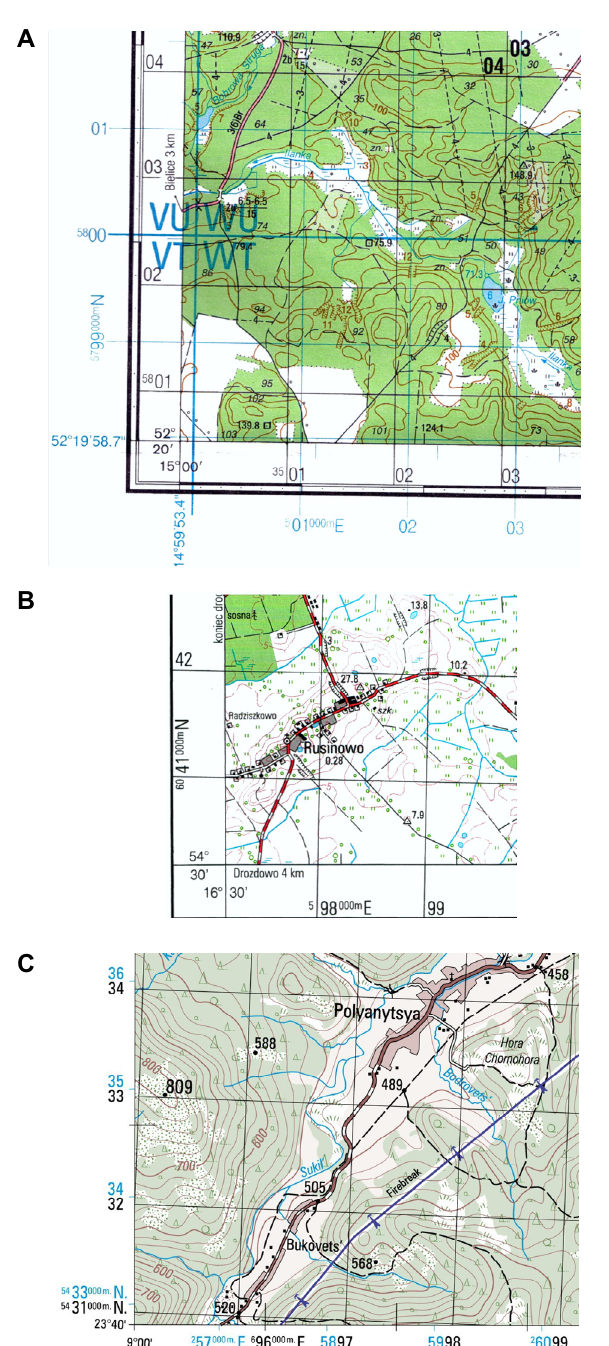
Fig. 1. Southwestern corners of military topographic maps in the scale of 1:50,000: A – map adapted to NATO standards, B – map in NATO standard, C – MDG